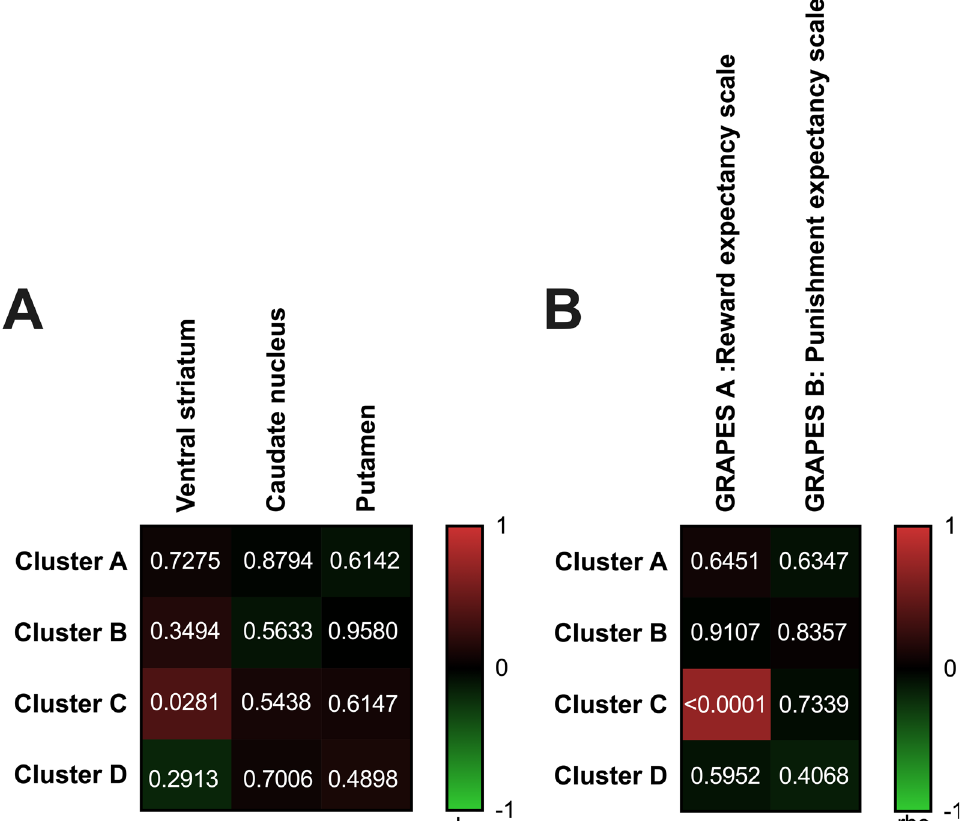
Fig. 2 Correlation of mean percentage of methylation (%) with a DAT availability and b GRAPES